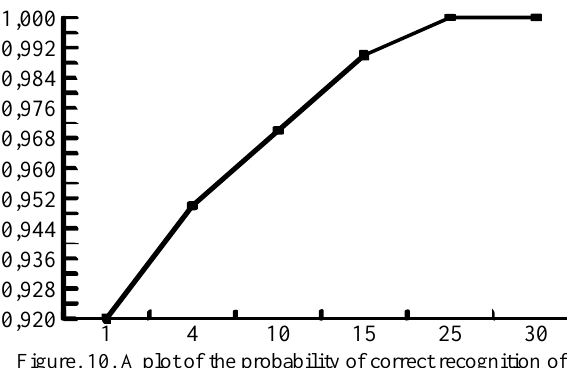
Figure. 10. A plot of the probability of correct recognition of complex object on the number of standards